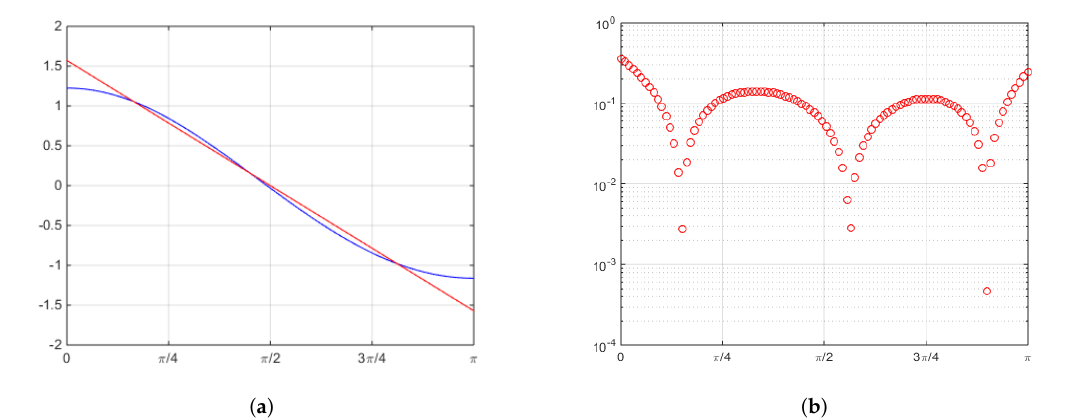
Figure 4. ( a ) Reconstructed potential (blue) and exact potential (red) p 2 ( x ) = π /2 − x ( b ) Log absolute error in the reconstructed p 2 .